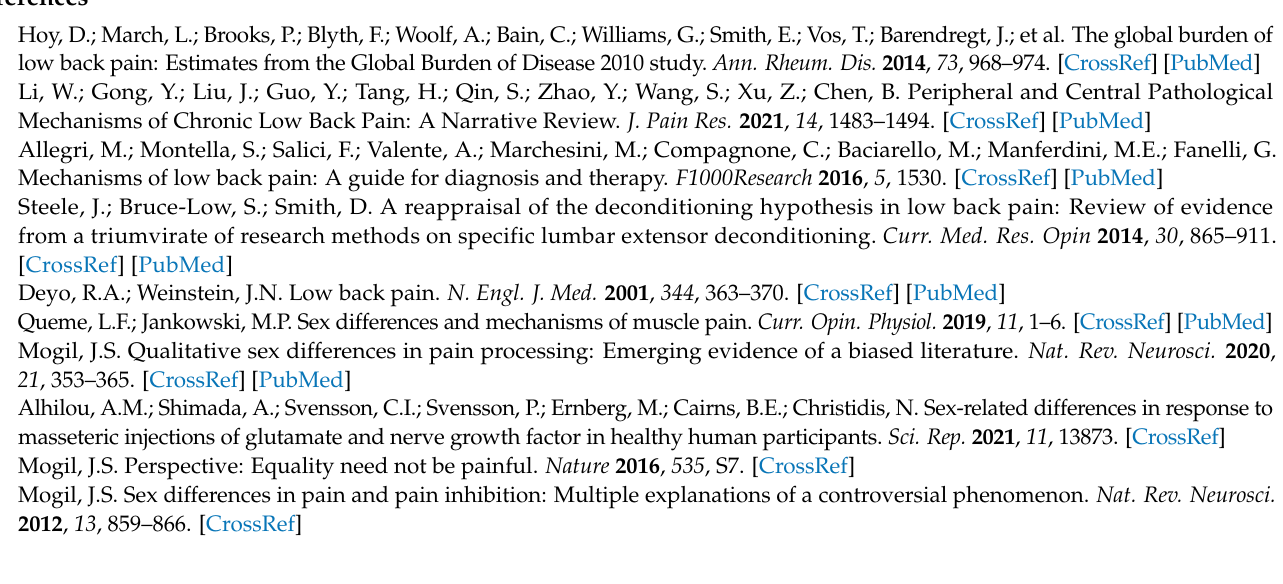
Figure S2: Females demonstrated a similar severity of ipsilateral and a greater severity of contralateral mechanical hypersensitivity to a 4 g cutaneous low back stimulus during persistent low back pain compared with males. (A) When compared to control (PBS), NGF injections (arrows, 0.8 µ M) resulted in ipsilateral low back mechanical hypersensitivity with an increased mean difference from baseline to a cutaneous 4 g filament stimulus from D7 to D17 in male rats and from D7 to D24 in female rats. No significant differences were found between males and females at any time points. (B) NGF injections (arrows, 0.8 µ M) resulted in contralateral low back mechanical hypersensitivity with an increased mean difference from baseline to a cutaneous 4 g filament stimulus at D7 through D17 in female rats. Females had significantly greater responses compared with males at D10, D14, and D17. Data are reported as means ± SD and analyzed by two-way ANOVA with Tukey’s multiple comparisons between groups for n = 8/group. * p < 0.01 vs. vehicle at the same time point and # p < 0.01 vs. NGF male contralateral at the same time